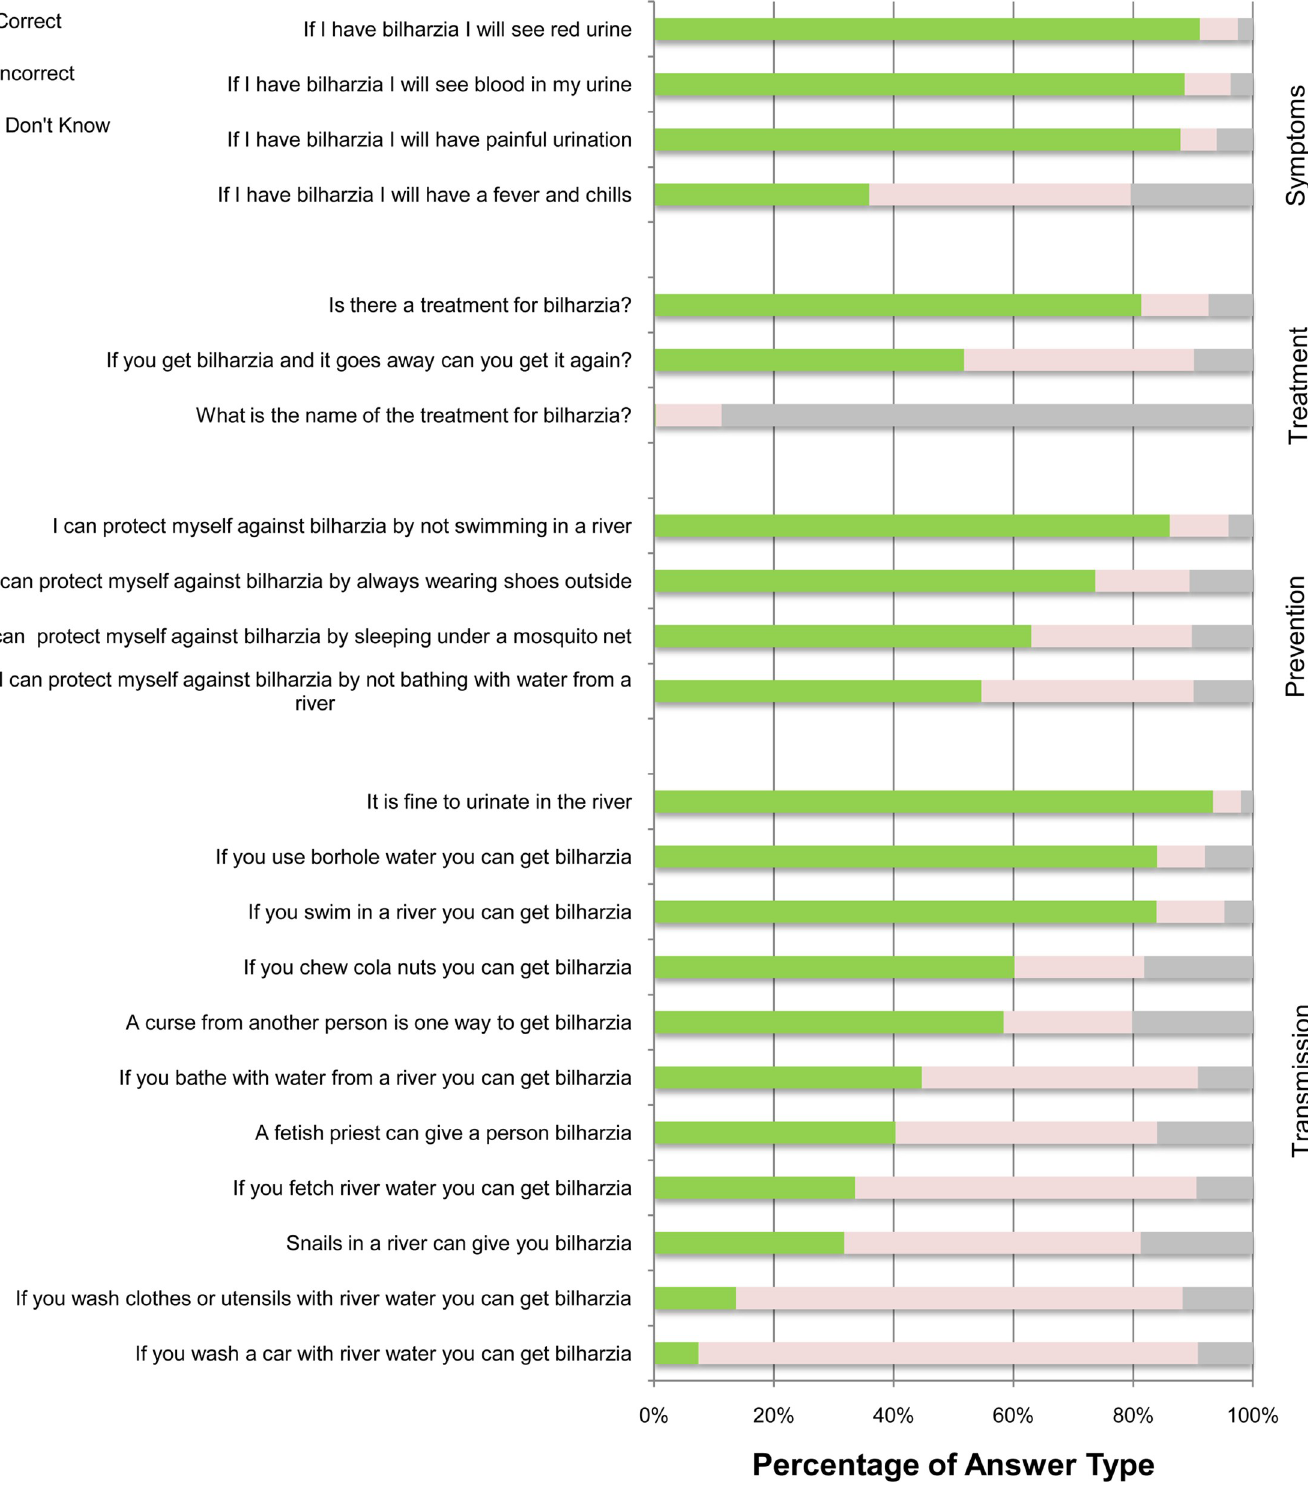
Fig 2. The distribution of responses to a 22-question UGS knowledge survey given to 1,813 schoolchildren from 37 towns in the Eastern Region of Ghana. 875 students were P4 and 938 were JHS2; coding: 1 = transmission, 2 = treatment, 3 = protective measures, and 4 = symptoms.